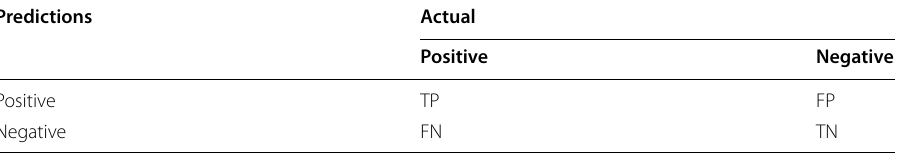
Table 1 Confusion matrix for binary